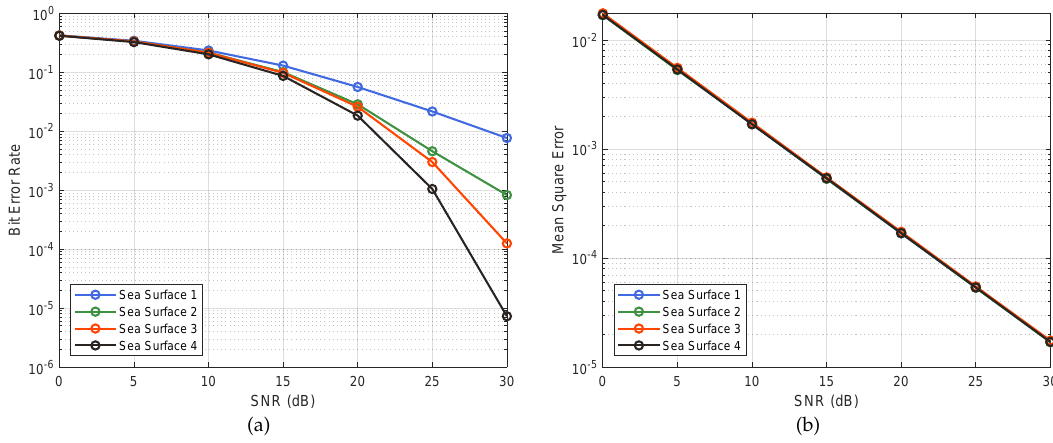
Figure 14. ( a ) BER performance of channels in different sea surfaces boundaries. ( b ) MSE performance of channels in different sea surfaces boundaries.